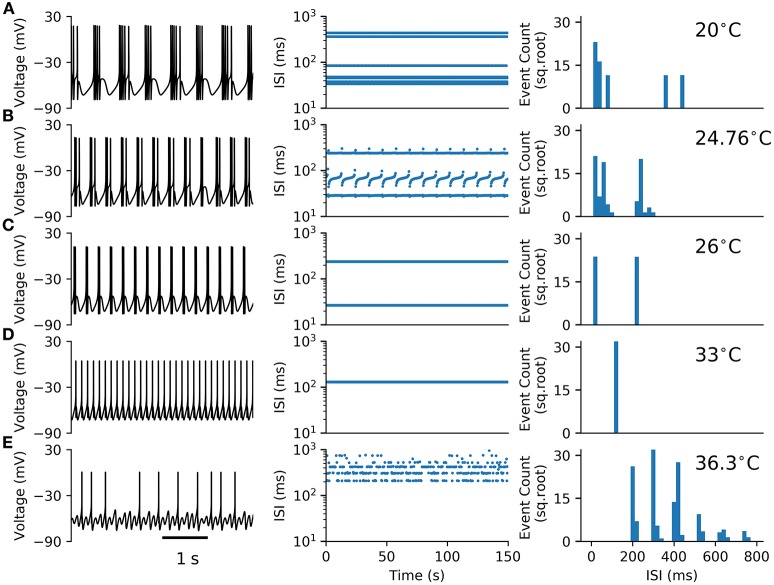
Firing patterns observed in the HB+Ih model. (A–E) Typical voltage time series (left), Inter-spike intervals (ISIs, middle) and ISI histograms (right) for the model at the shown temperatures. In (A–D) the histograms consider around 1100 spikes from 150 s simulations. In (E), the histogram was built from 2977 spikes obtained in a 1000 s simulation.